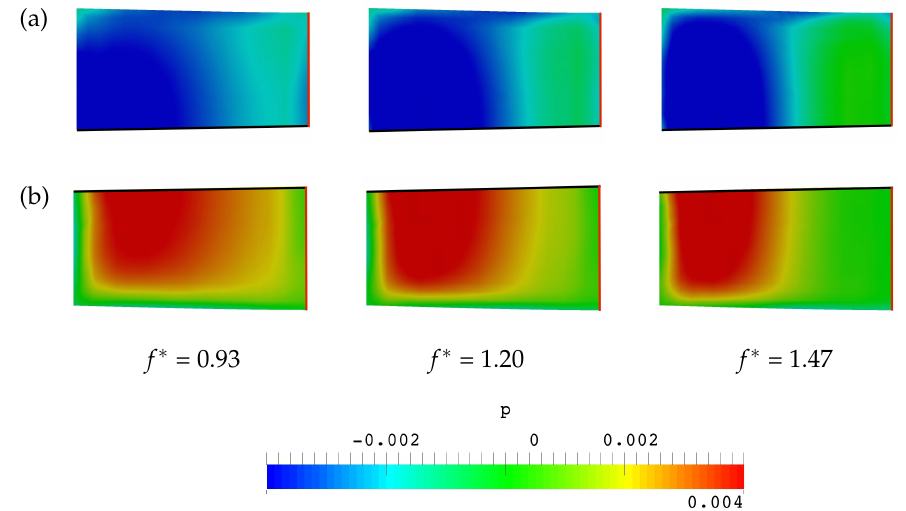
Figure 12. Pressure distributions on the; ( a ) top and ( b ) bottom surfaces of the plate at a phase instant when a peak value of positive thrust appears in each case (The symmetry plane and leading edge are represented by a black line and red line,